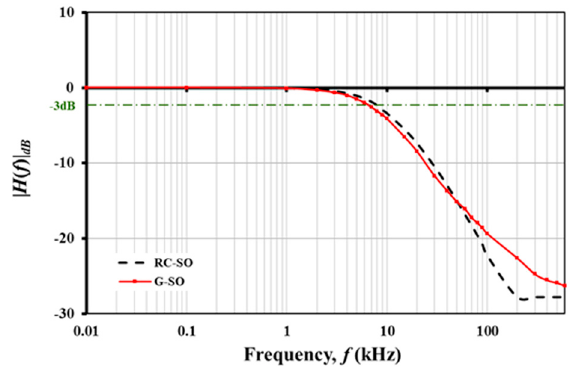
Figure 7. Comparison of second-order G-CMC low pass filter performance with equivalent conventional RC circuit. Note that the second order filter roll-off rate was roughly twice of first order circuit. As expected, f c value did not differ between first and second-order low pass filters. The output voltage signal was detectable beyond 600 kHz.